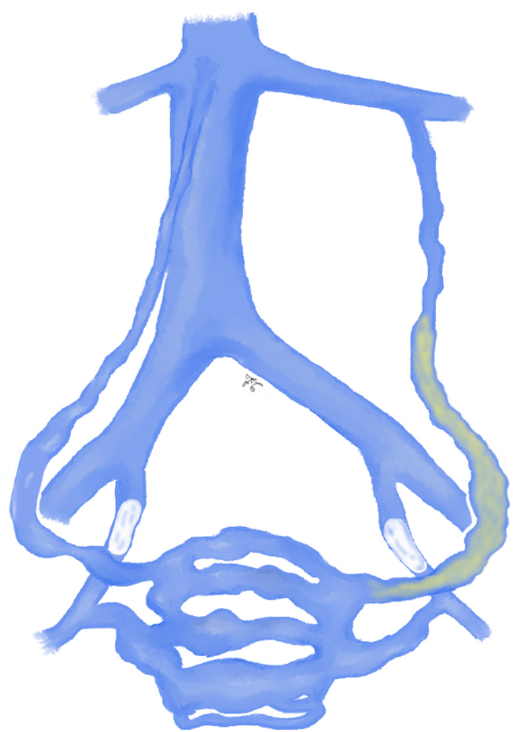
Figure 7. Drawing shows left ovarian vein embolization using the stop-flow foam sclerotherapy (SFFS) reported by Gandini et al. [82]: the sclerosing agent was injected into the pelvic vessels after having inflated the balloon catheter to occlude the major tributary vessels (hypogastric and/or ovarian veins) and excluding high-outflow venous collaterals.